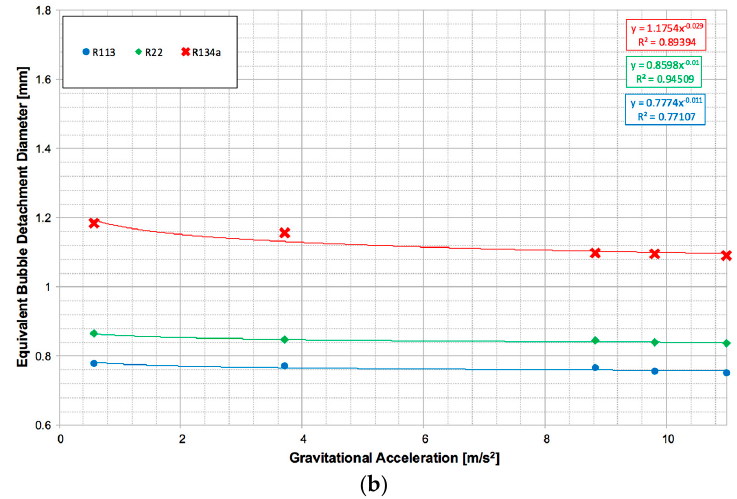
Figure 26. Effect of gravity level on: ( a ) the bubble detachment time; ( b ) the equivalent bubble detachment diameter (cases D1–D15, with the 1 bar ambient pressure condition). Energies 2017 , 10 , 272